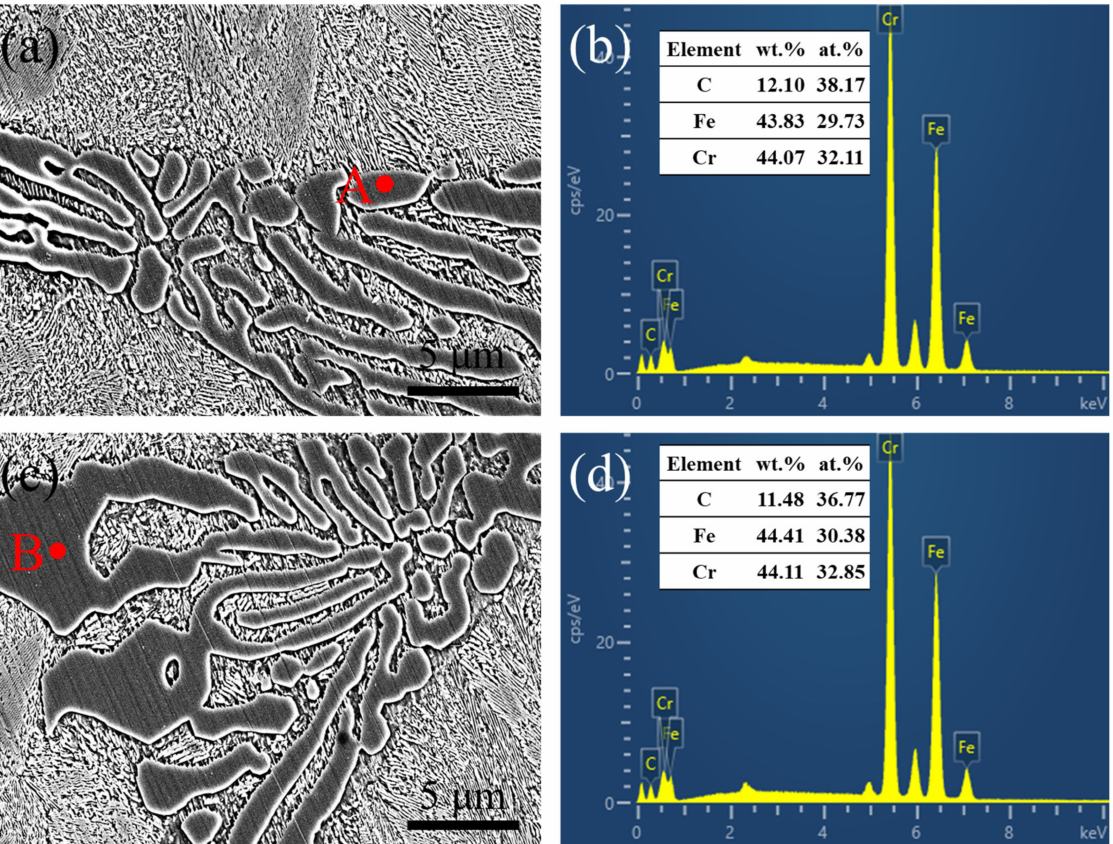
Figure 4. SEM images of the microstructures around the eutectic carbides and corresponding EDS analysis. ( a ) CIL-2; ( b ) EDS result of point A; ( c ) CIL-4; ( d ) EDS result of point